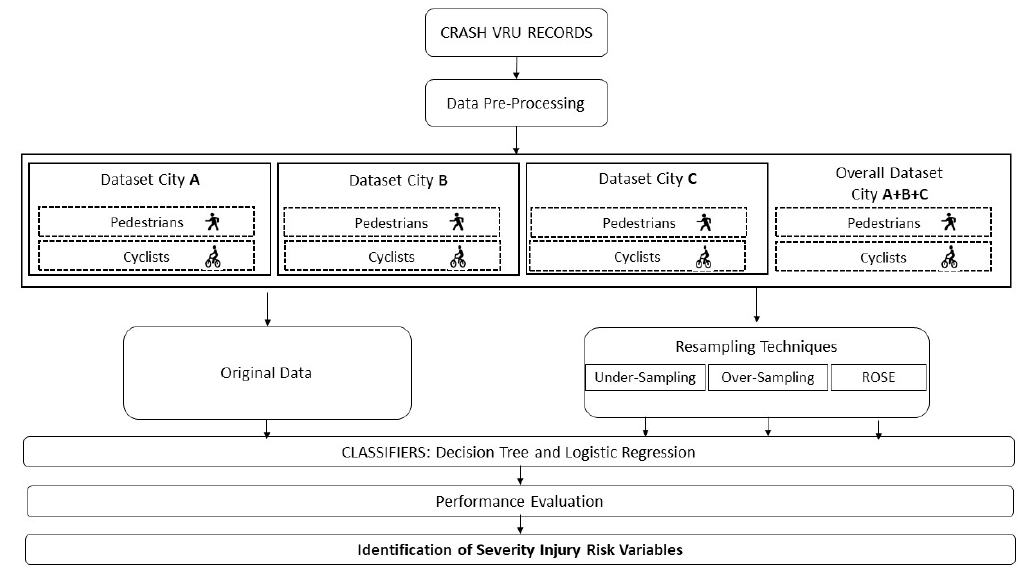
Figure 1. Overview of the methodology process.